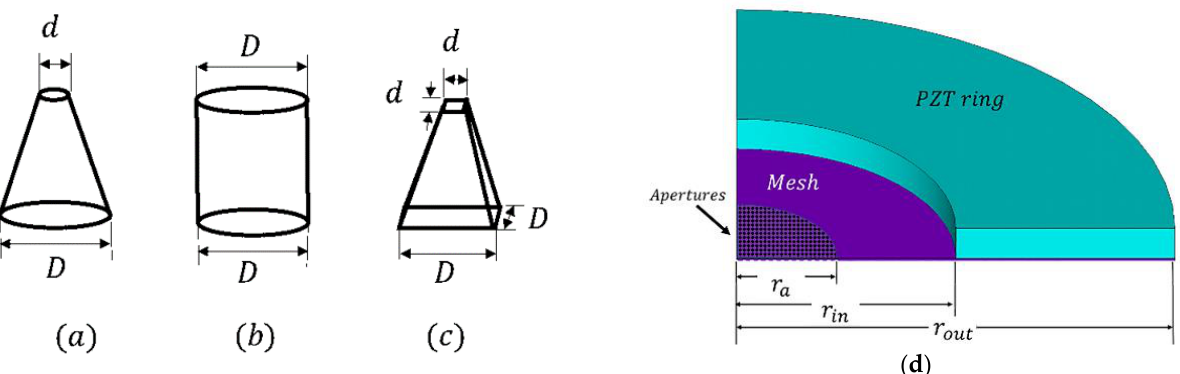
Figure 7. Geometrical shapes of the micro-apertures of ( a ) conical, ( b ) cylindrical, and ( c ) pyramidal holes. ( d ) Section view of a solid model of the atomizer disc with micro-apertures on the meshed thin plate.